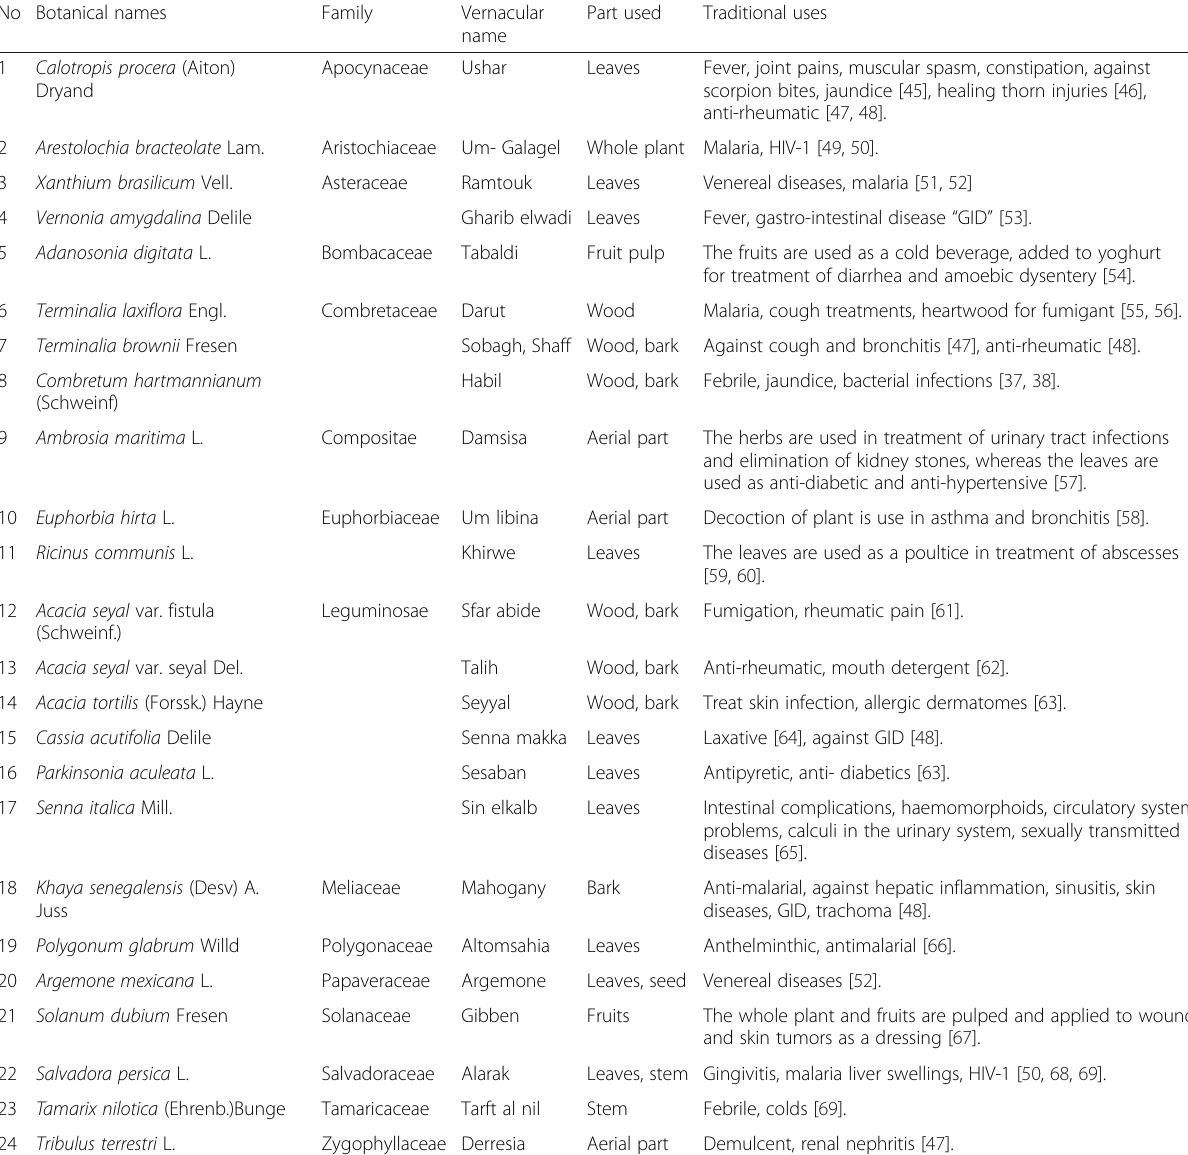
Table 1 Selected Sudanese medicinal plant species used in traditional